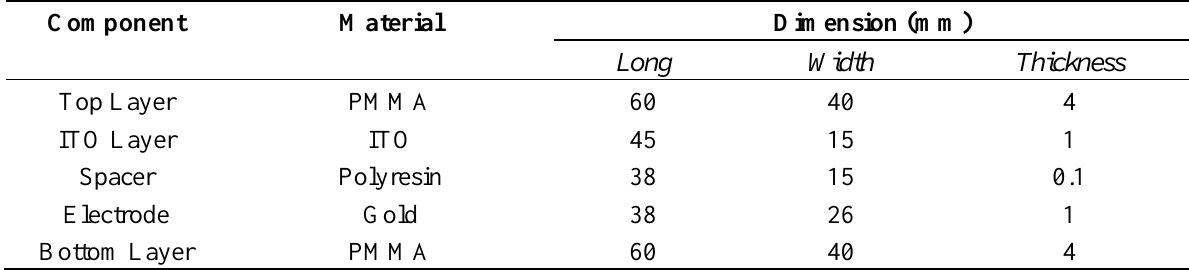
Table 2. Design specifications of the different layers of the proposed LOC